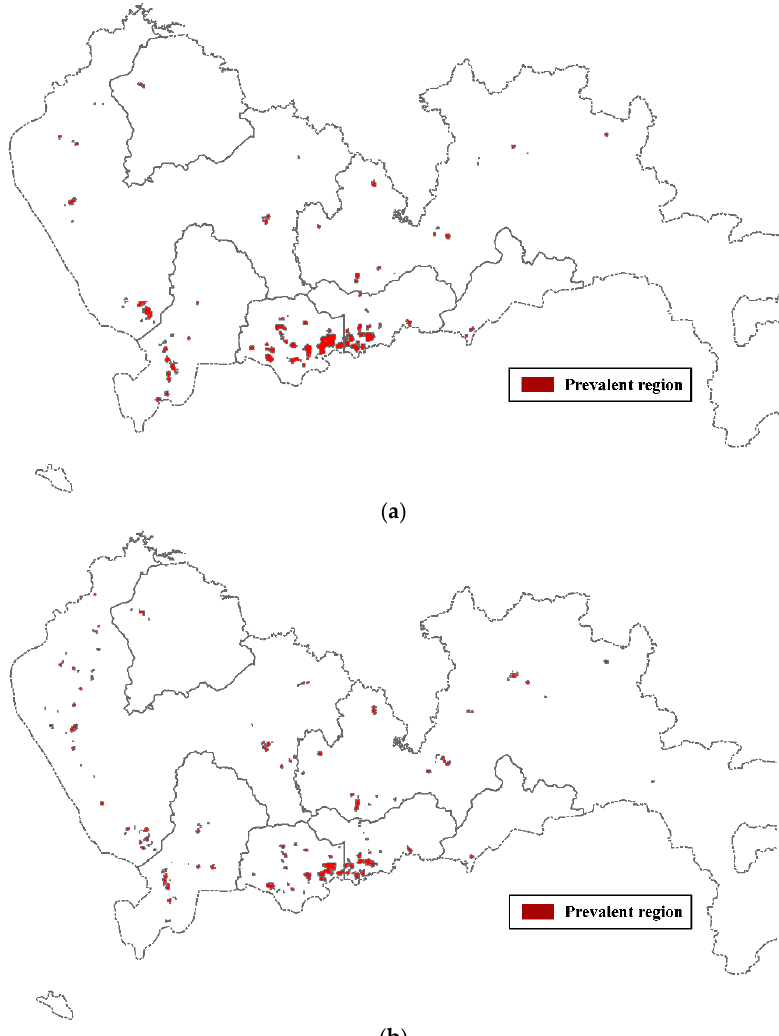
Figure 7. The prevalence surfaces created by combining multiple kernel density estimation surfaces with respect to the: ( a ) size-2 pattern {bank, retail store}; and ( b ) size-3 pattern {bank, retail store, hotel}.